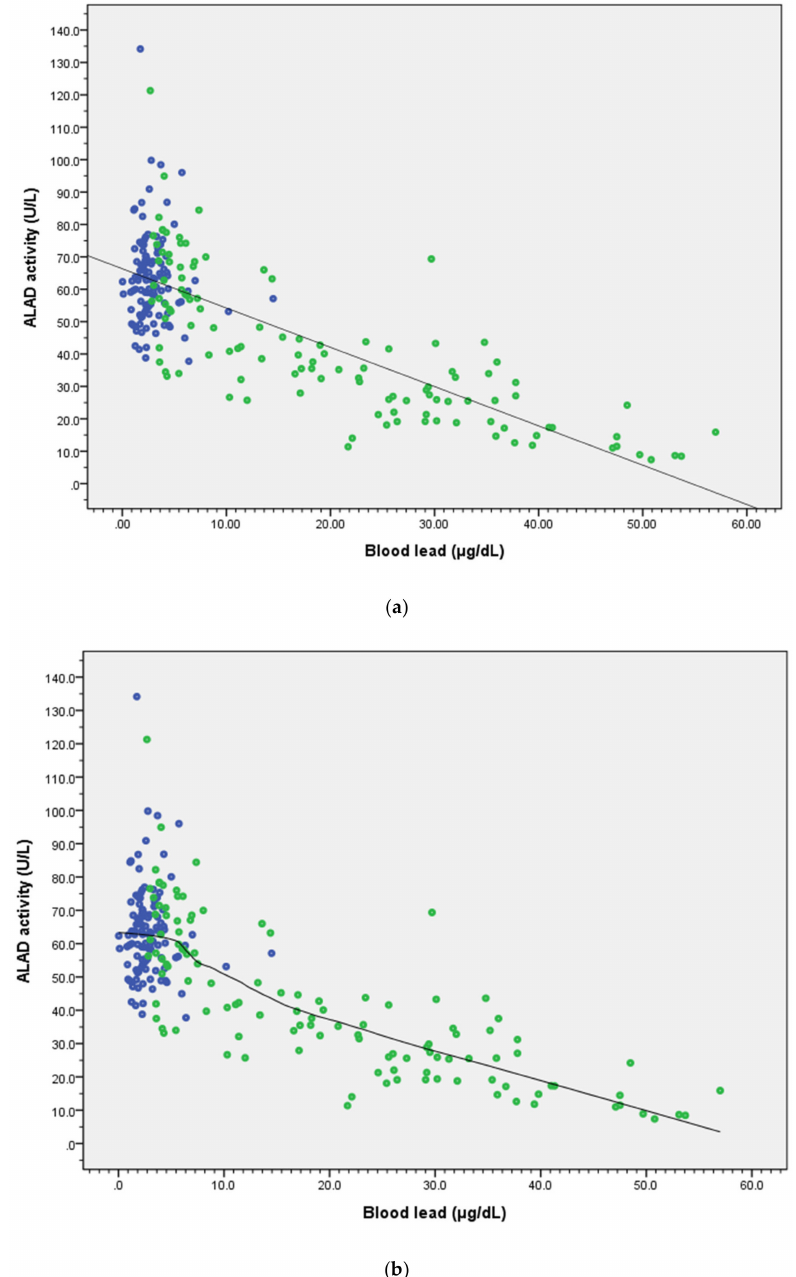
Figure 1. Association of blood lead concentration (ug / dL) and δ -aminolevulinic acid dehydratase (ALAD) activity in lead-exposed group (green dots, n = 116) and control group (blue dots, n =